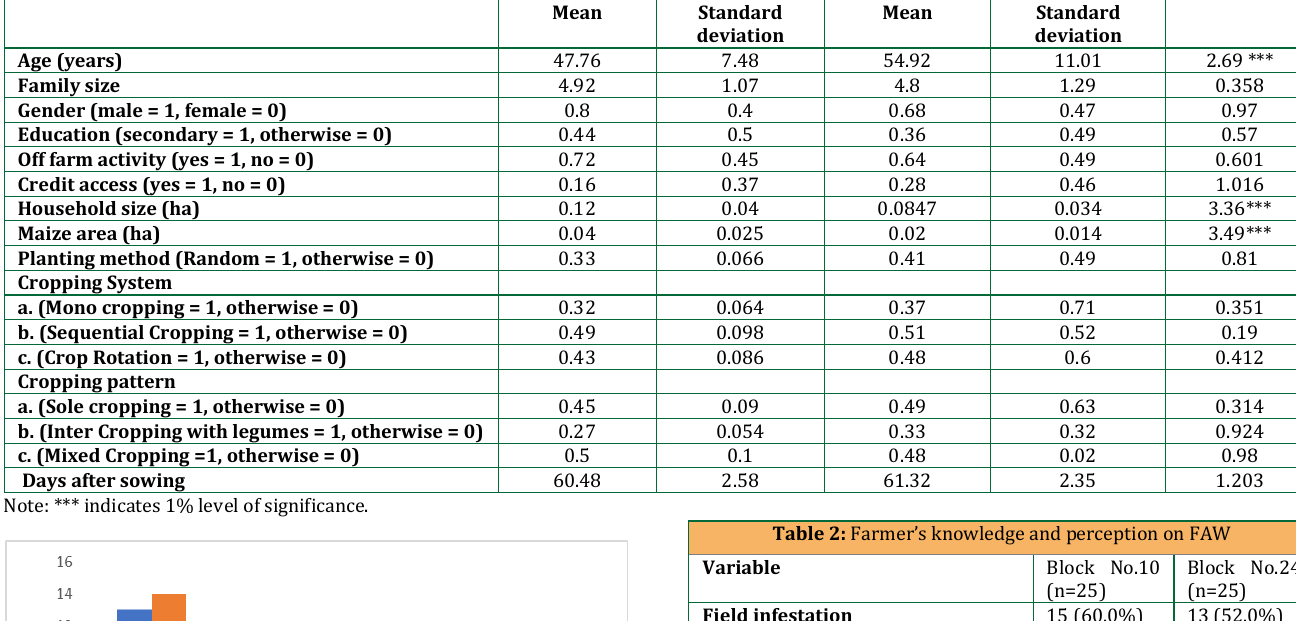
Table 1: Demographic and Socio-economic characteristics of household head Variable